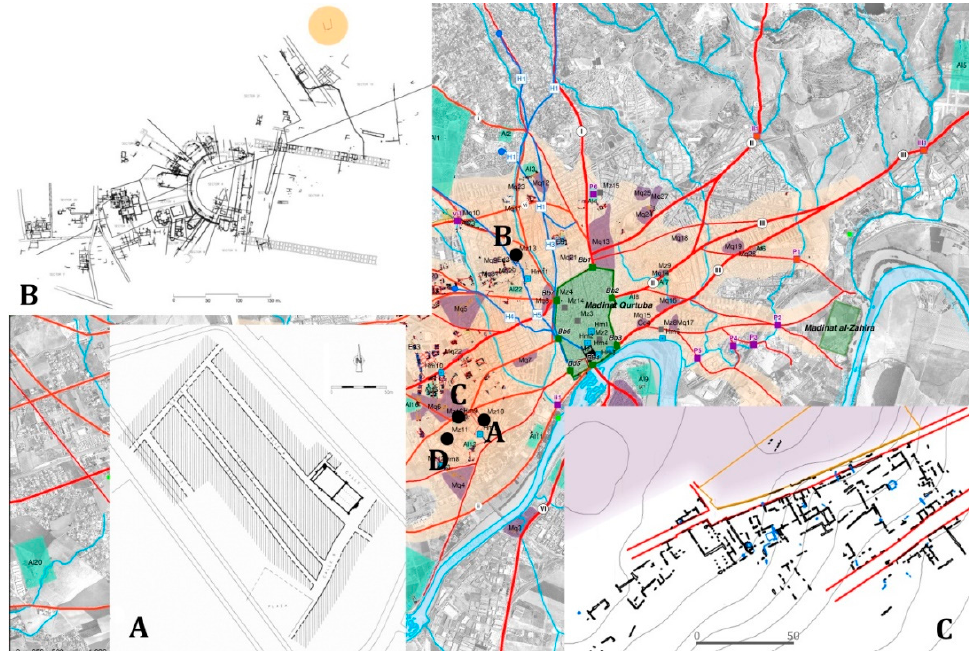
Figure 6. New mosques built during the Caliphate in the western and northern suburbs. ( a ) Mosque of Fontanar (Luna and Zamorano 1999, p. 168, Figure 2). ( b ) Mosque in the bus station (González Gutiérrez 2016 a , p. 442, Figure 238). ( c ) Mosque of Naves de Fontanar (Vaquerizo and Murillo 2010, p. 665, Figure 350). ( d ) Mosque in Centro de Transfusión. Basis plan: Vaquerizo and Murillo 2010, p. 541, Figure 251. All images used by the permission of authors.